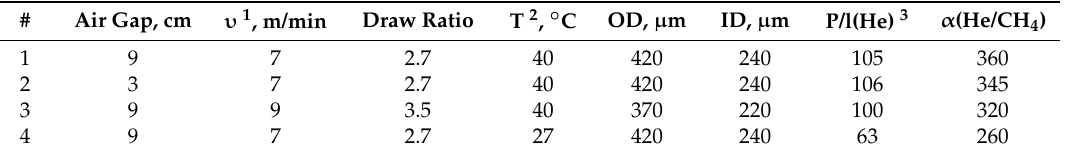
Table 1. The influence of spinning parameters on the hollow fiber’s geometrical and separation characteristics. OD—Outer diameter; ID—Internal